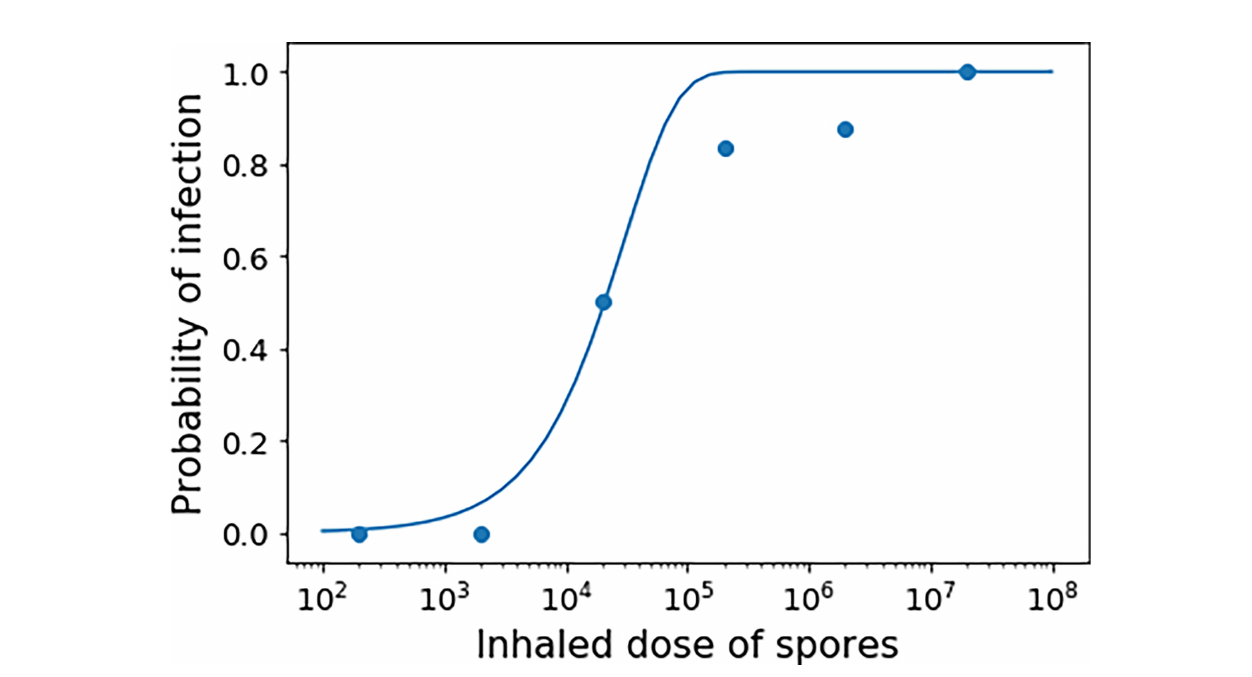
FIGURE 8 | Exponential dose-response curve fi t to the Altboum et al. guinea-pig Vollum strain dose-response data set (33). Here the probability that one inhaled spore will cause a response is set to r = 3.31 × 10 -5